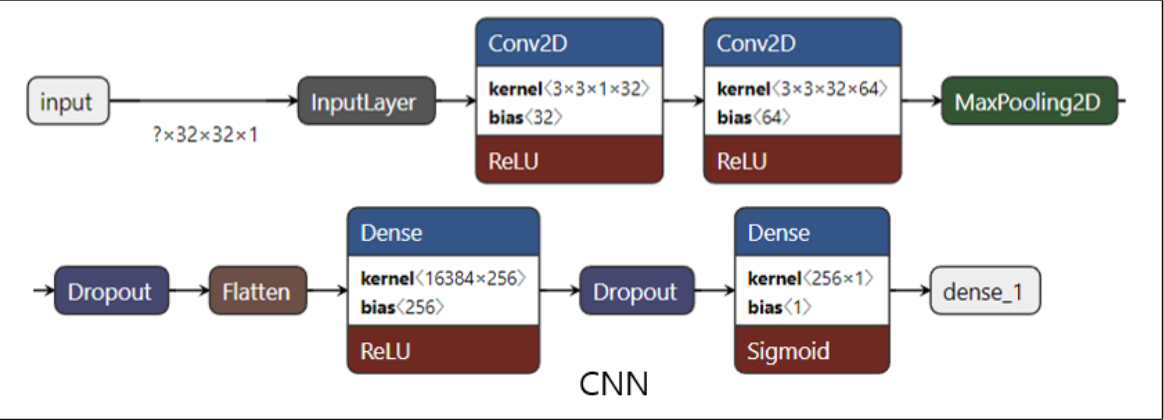
Figure 11. CNN model architecture.